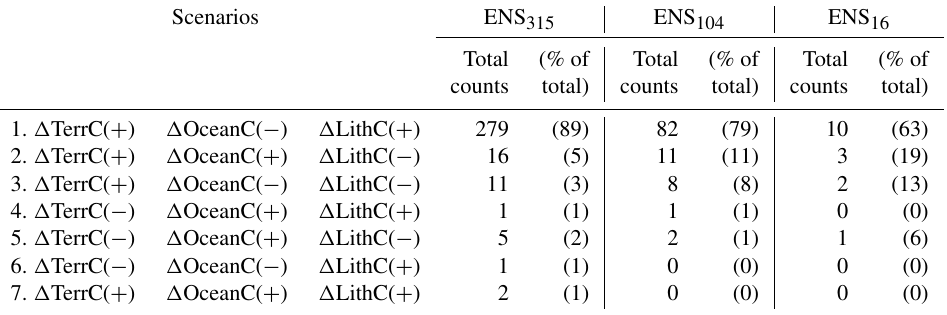
Table 3. LGM-PRE carbon partitioning scenarios in ENS 315 , ENS 104 and ENS 16 .